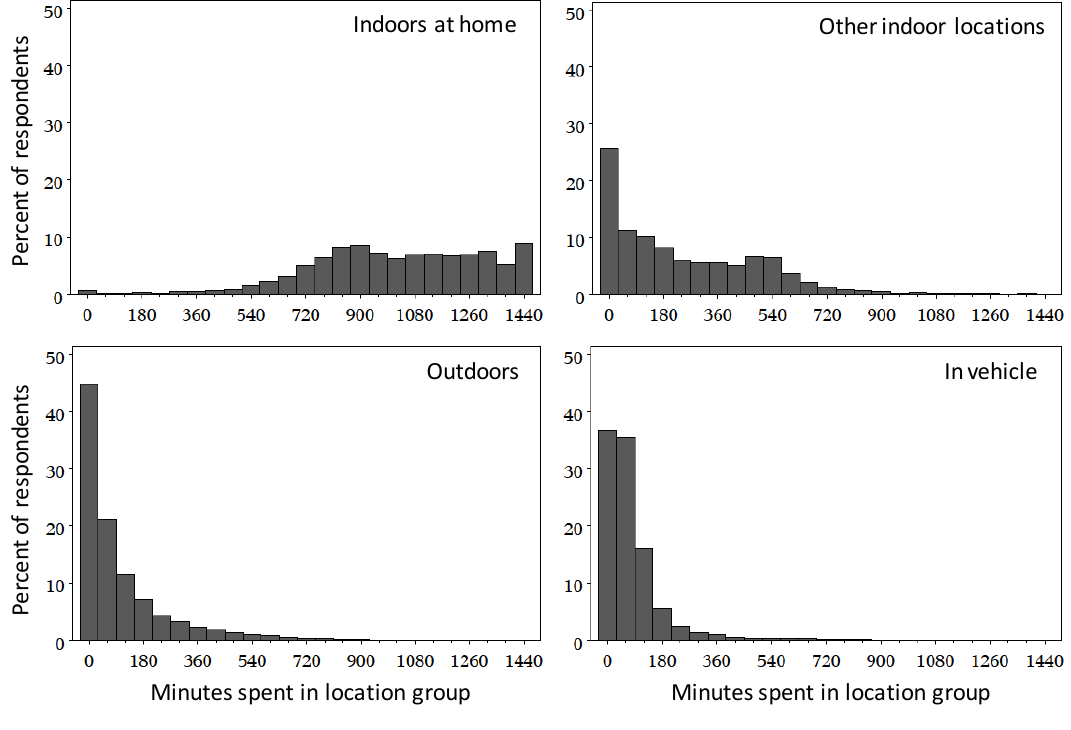
Figure 1. Distributions of time spent indoors at home, other indoor locations, outdoors, and in vehicle for all CHAPS 2